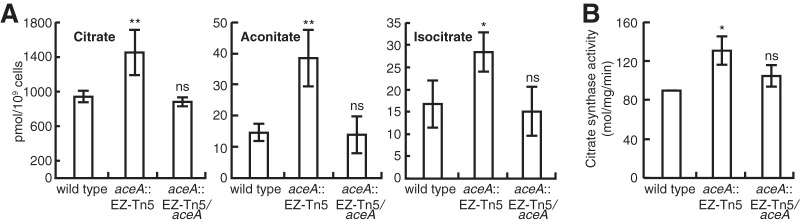
The aceA mutant experiences physiological stresses due to metabolic imbalance. (A) Concentrations of citrate, aconitate, and isocitrate were higher in the aceA mutant than in the wild-type strain. (B) Citrate synthase activity was higher in the aceA mutant than in the wild-type strain. Error bars represent the error ranges of experiments performed in triplicate. ns, no significant difference; *, P ≤ 0.1; **, P < 0.05.